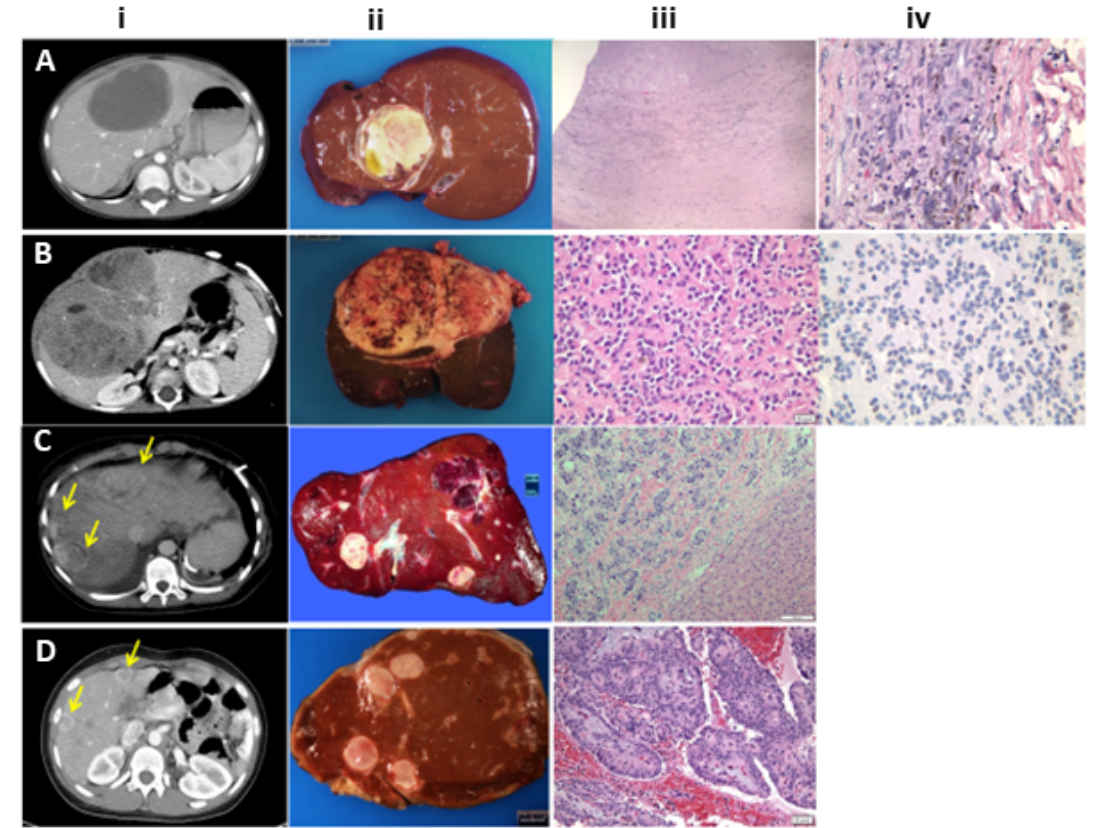
Figure 2. ( A ). First row: Undifferentiated embryonal sarcoma: i. Contrast-enhanced CT image with a hypodense mass in segment IV ii: Liver explant with a large yellowish necrotic tumor. iii: H&E